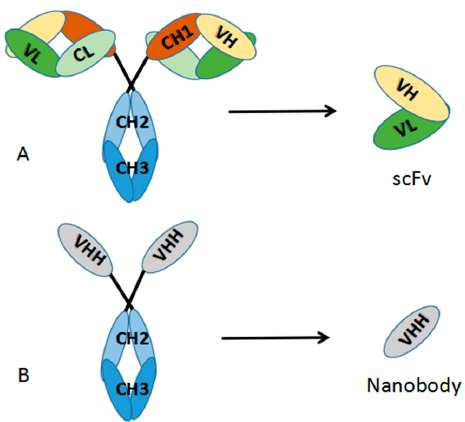
Figure 2. Schematic presentation of a ( A ) conventional antibody (IgG) and ( B ) heavy chain antibody, with their antigen-binding fragments ( A ) scFv and ( B ) VHH.